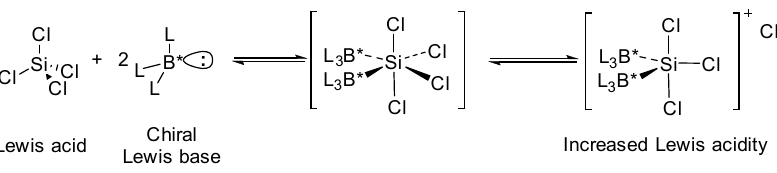
Figure 1. Formation of hypervalent silicon species.